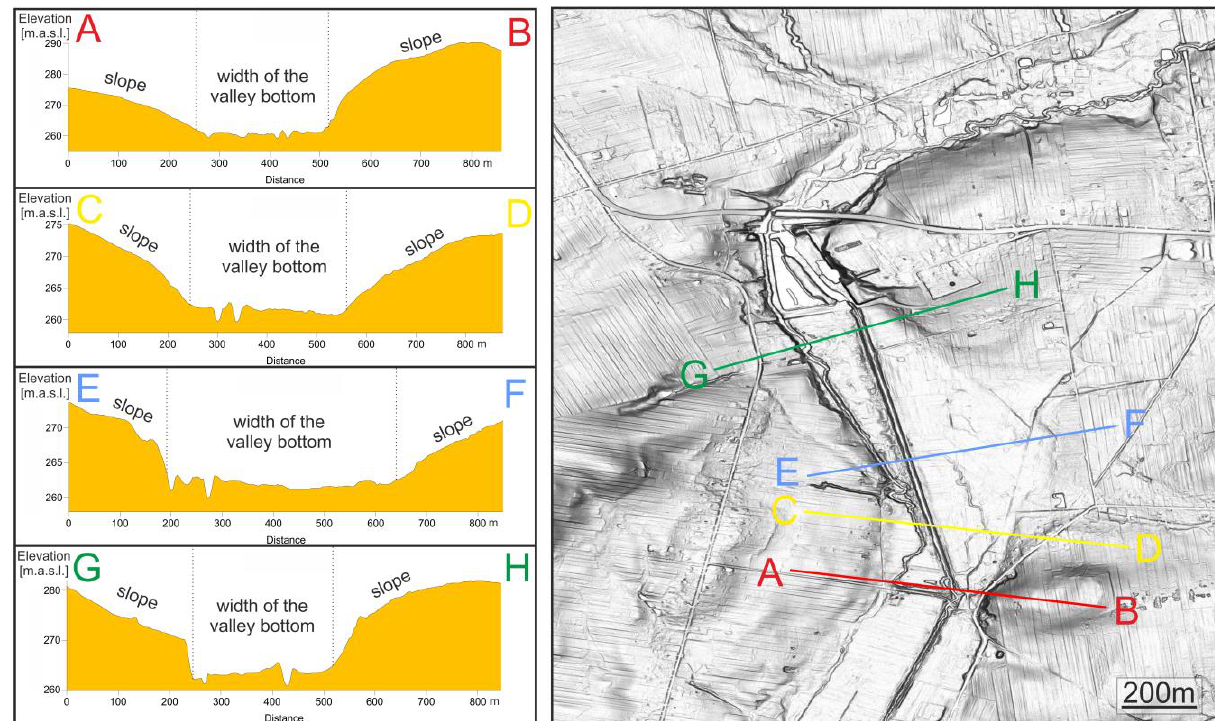
Fig. 3. Location of the Bobrza former ironworks on the shaded relief map with cross section lines representing valley relief indicated